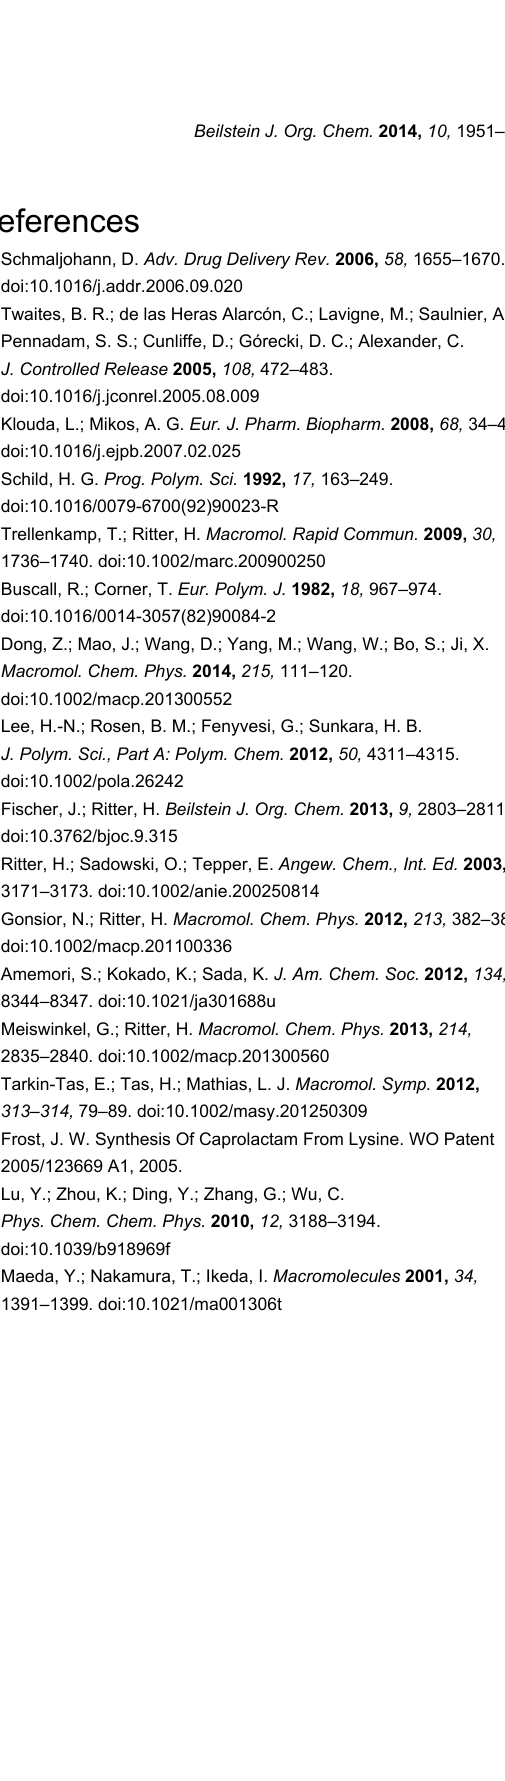
Table 1: Monomer amount of 4 and 5 for the copolymerization of copolymers 6a–i .